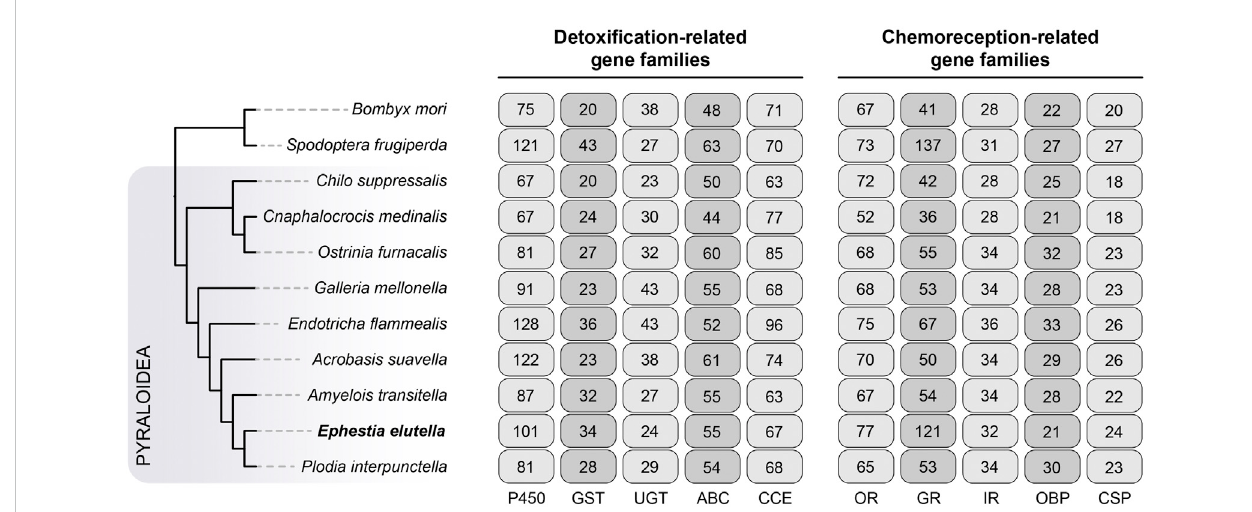
FIGURE 3 Evolution of chemoreception- and detoxi fi cation-related gene families in Pyraloidea. Nine species from Pyraloidea were included in our analysis, andthesilkworm Bombyxmori andthefallarmyworm Spodopterafrugiperda wereusedastheoutgroups.Thephylogeneticrelationshipofthesespecies is obtained from Figure 1A. A total of fi ve representative gene families of chemoreception- and detoxi fi cation-related gene families were analyzed respectively, and thegenenumbersofthese genefamiliesareindicatedontheright.P450,cytochromeP450;GST,glutathioneS-transferase;UGT, UDP glycosyltransferase; ABC, ATP-binding cassette transporter; CCE, carboxyl/choline esterase; OR, olfactory receptor; GR, gustatory receptor; IR, isotonic receptor; OBP, odorant-binding protein; CSP, chemosensory